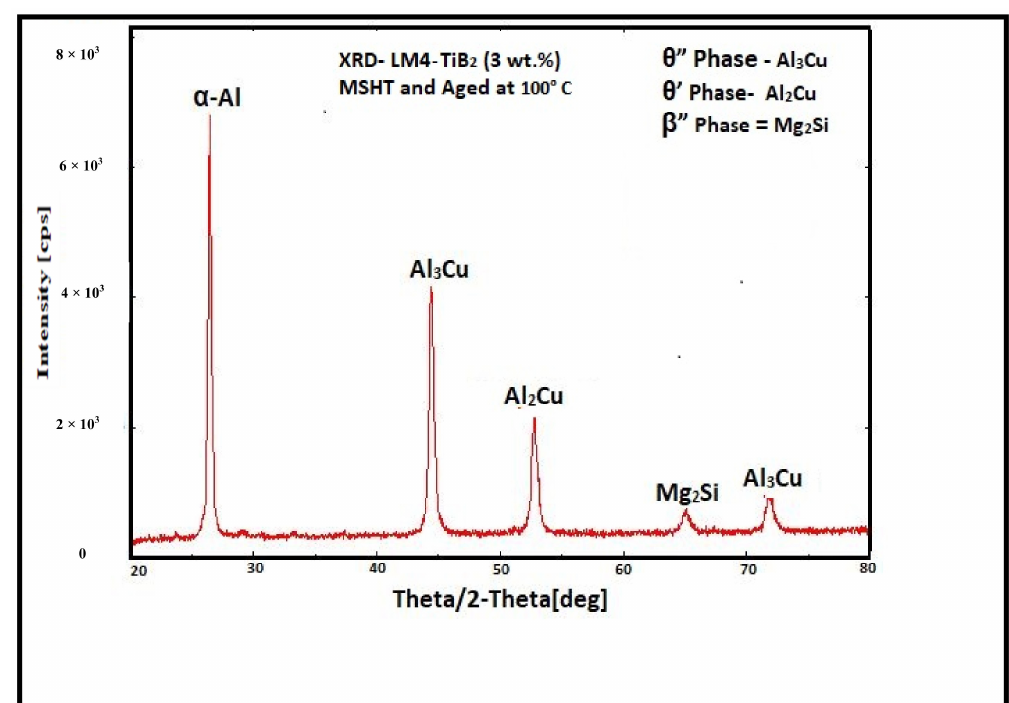
Figure 13. XRD of the LM4 + 3 wt.% TiB 2 composite sample (MSHT and aged at 100 ◦ C) to confirm the presence of different types of precipitates.